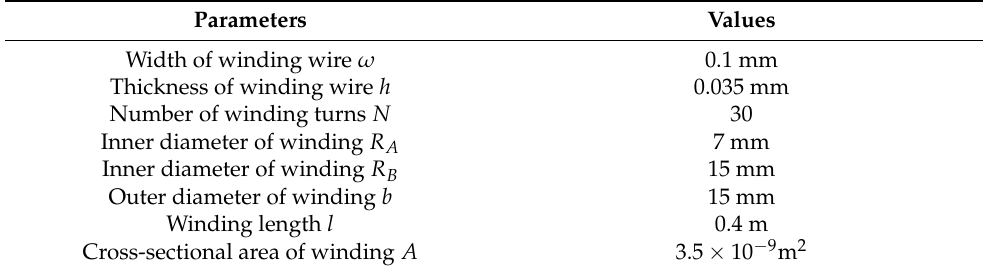
Table 1. Winding parameters of the coils.